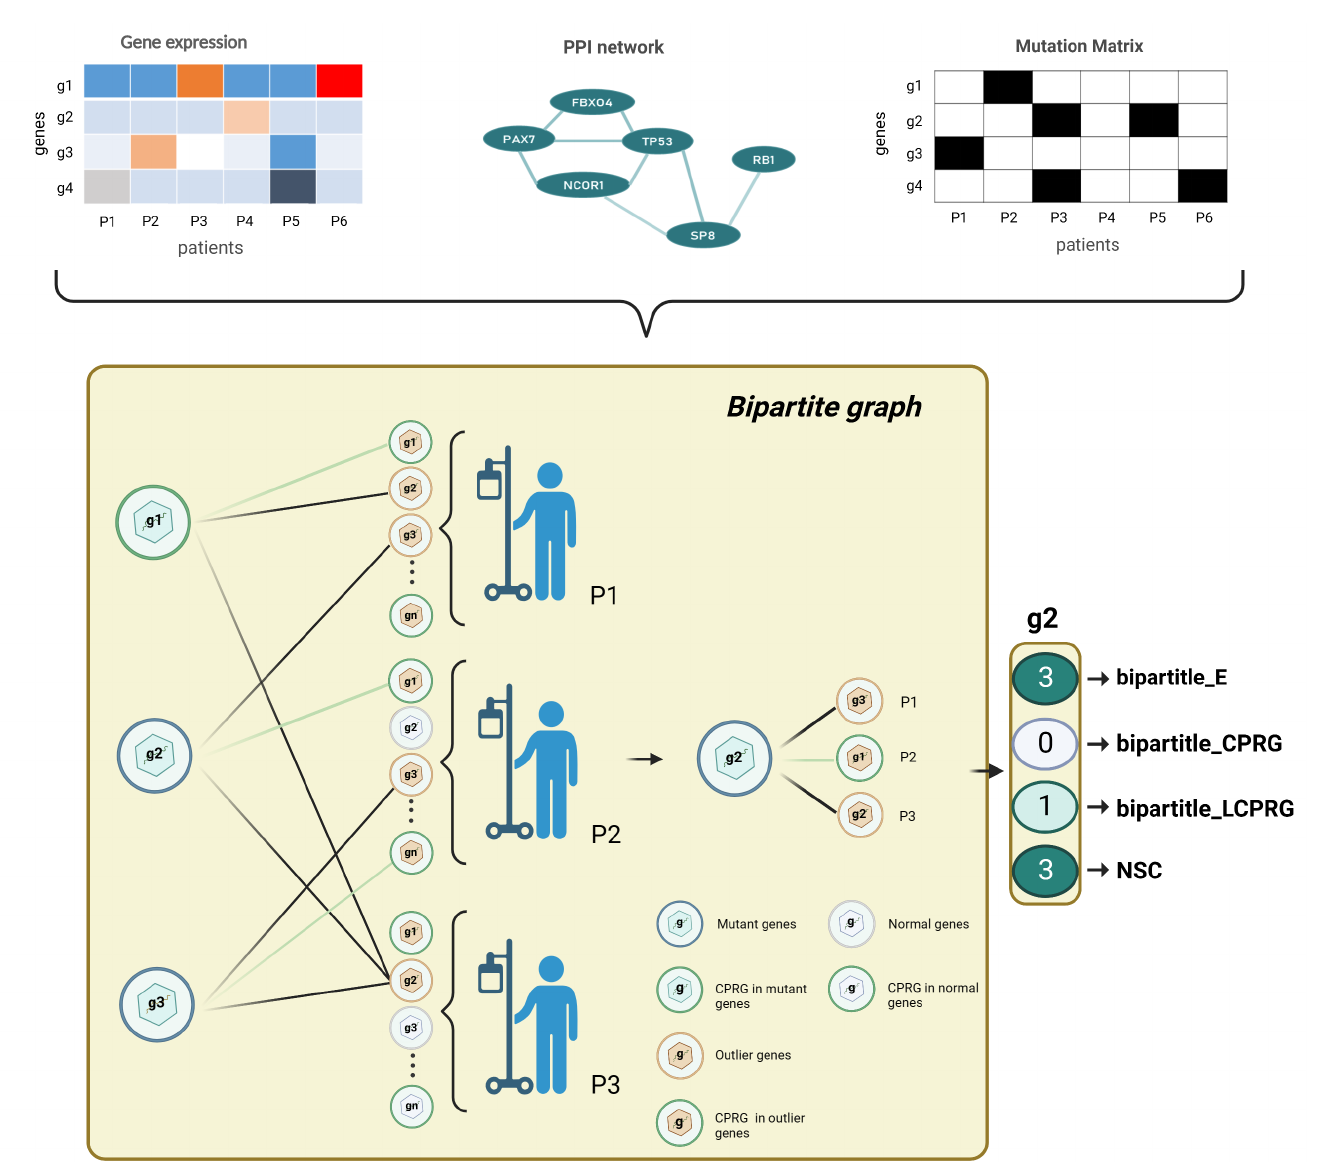
Figure 2. Bipartite graph architecture. For each tumor type, we built a bipartite graph by gene expression data, mutation data, and PPI network. We finally output a 4 × n dimensional feature matrix (n is the number of genes to be predicted). The left partition of the bipartite graph is the mutated genes, and the right partition of the bipartite graph is the outlying expression status for each tumor sample. bipartite _ E represents the number of edges of a mutated gene; bipartite _ LCPRG denotes the number of edges of a mutated gene linked to CPRGs; bipartite _ CPRG is a binary number: if a gene was a CPRG, we set the bipartite _ CPRG feature of the gene as 1, otherwise 0; NSC is the number of patients covered by a mutated